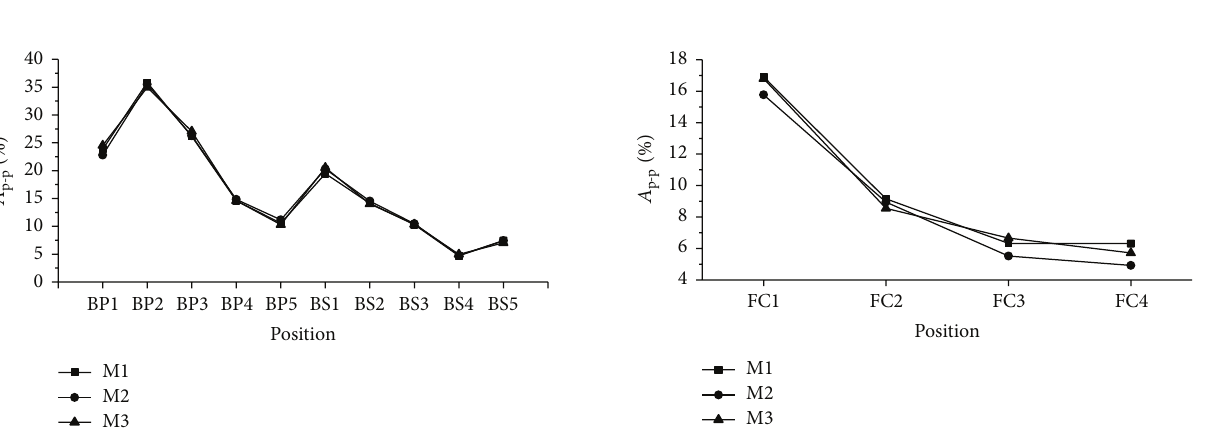
Figure 9: Peak-peak amplitudes at the points in impeller. Figure 10: Peak-peak amplitude at the points in the front